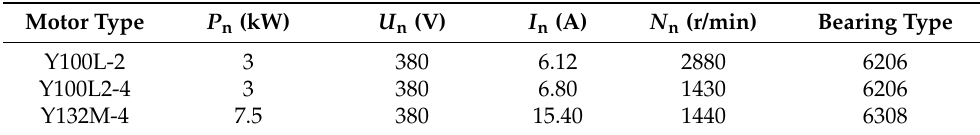
Table 2. Rated values and bearing types of tested motors.